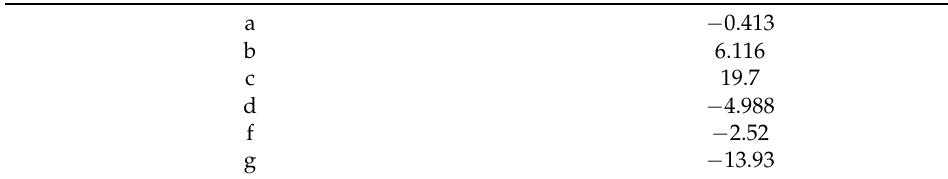
Table 7. Coefficients for the fitting fuction of Nao.